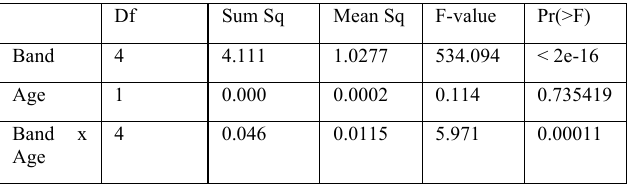
Table I . ANOVA results for power ~ age x frequency band